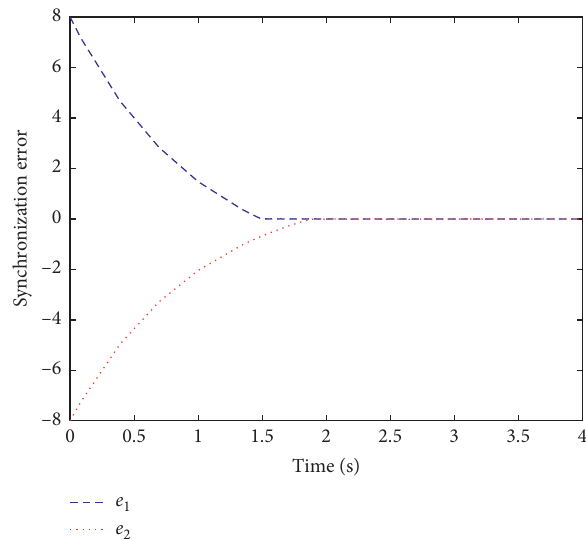
Figure 3: Finite-time stability based on the controller (49) with